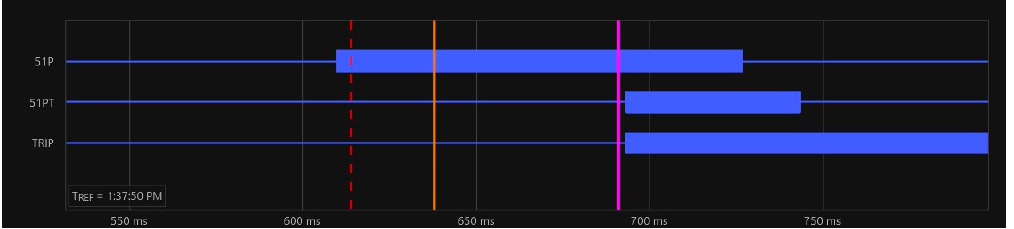
Figure 37. Trip signal generated by R2 under IDMT scheme.